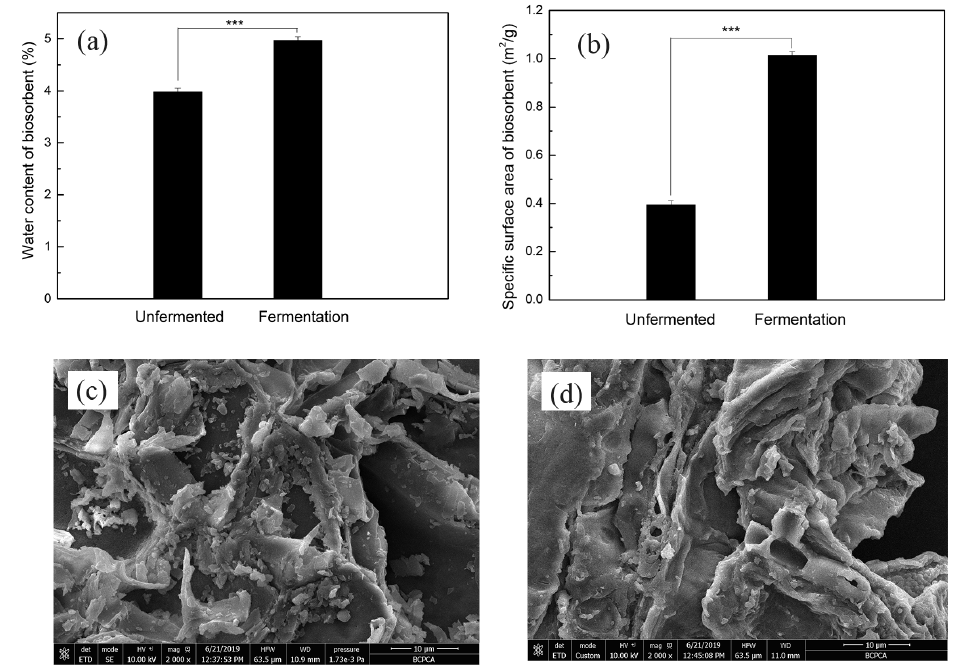
Figure 5: Comparison of water content (a), specific surface area (b) and surface morphology of Magnolia officinalis adsorbent before (c) and after fermentation (d). (The statistical significance difference (p<0.001) is marked).